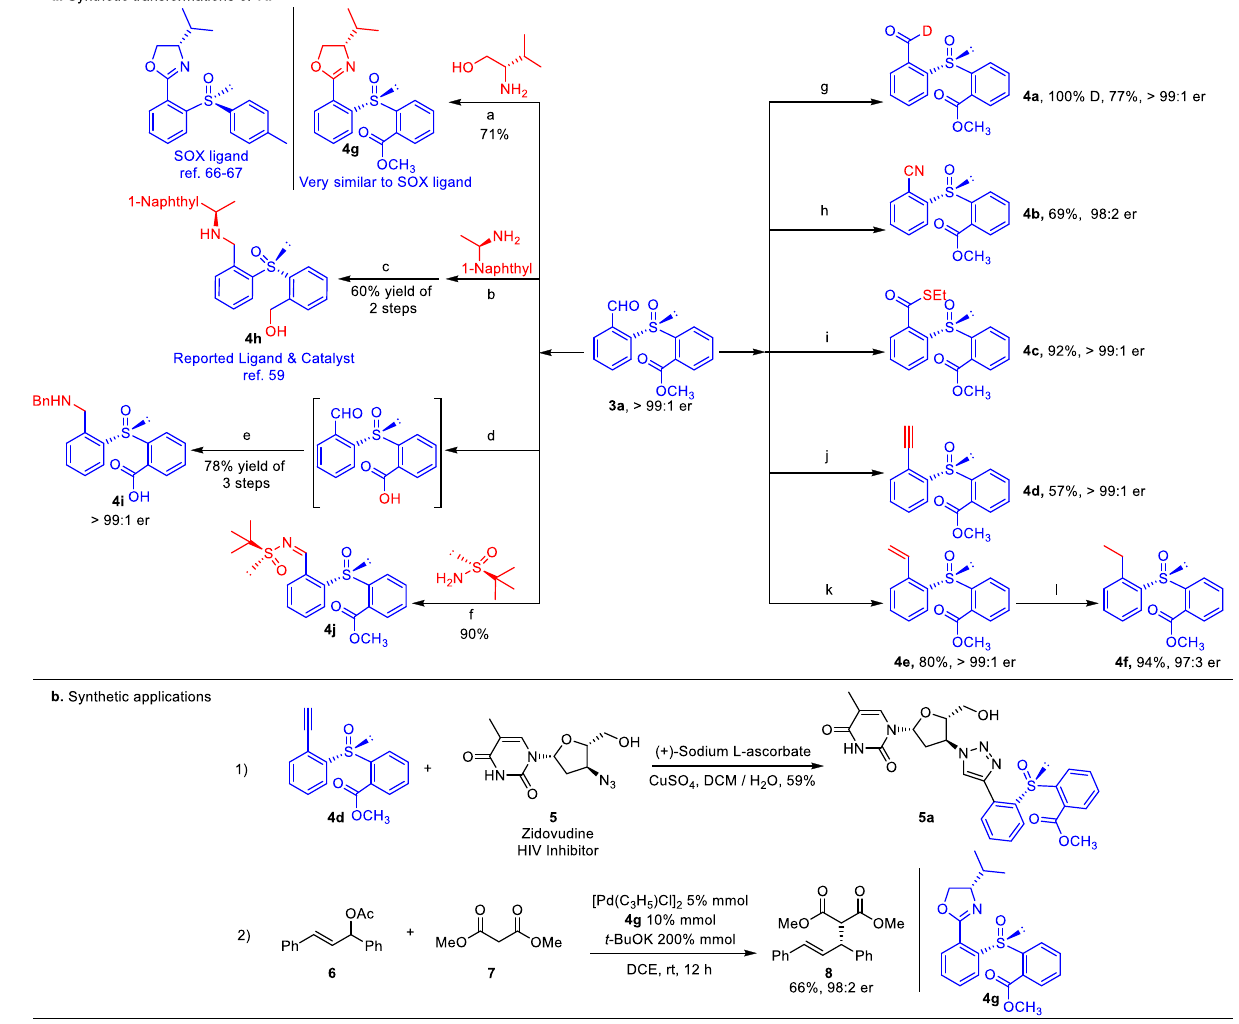
Fig. 3 | Synthetic transformations and applications. a K 3 PO 4 , NBS, 4Å MS, 30°C, toluene; b